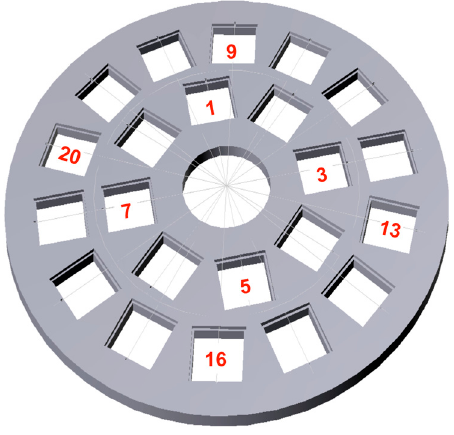
Figure 11. Scheme of the samples selected for the weight analysis.